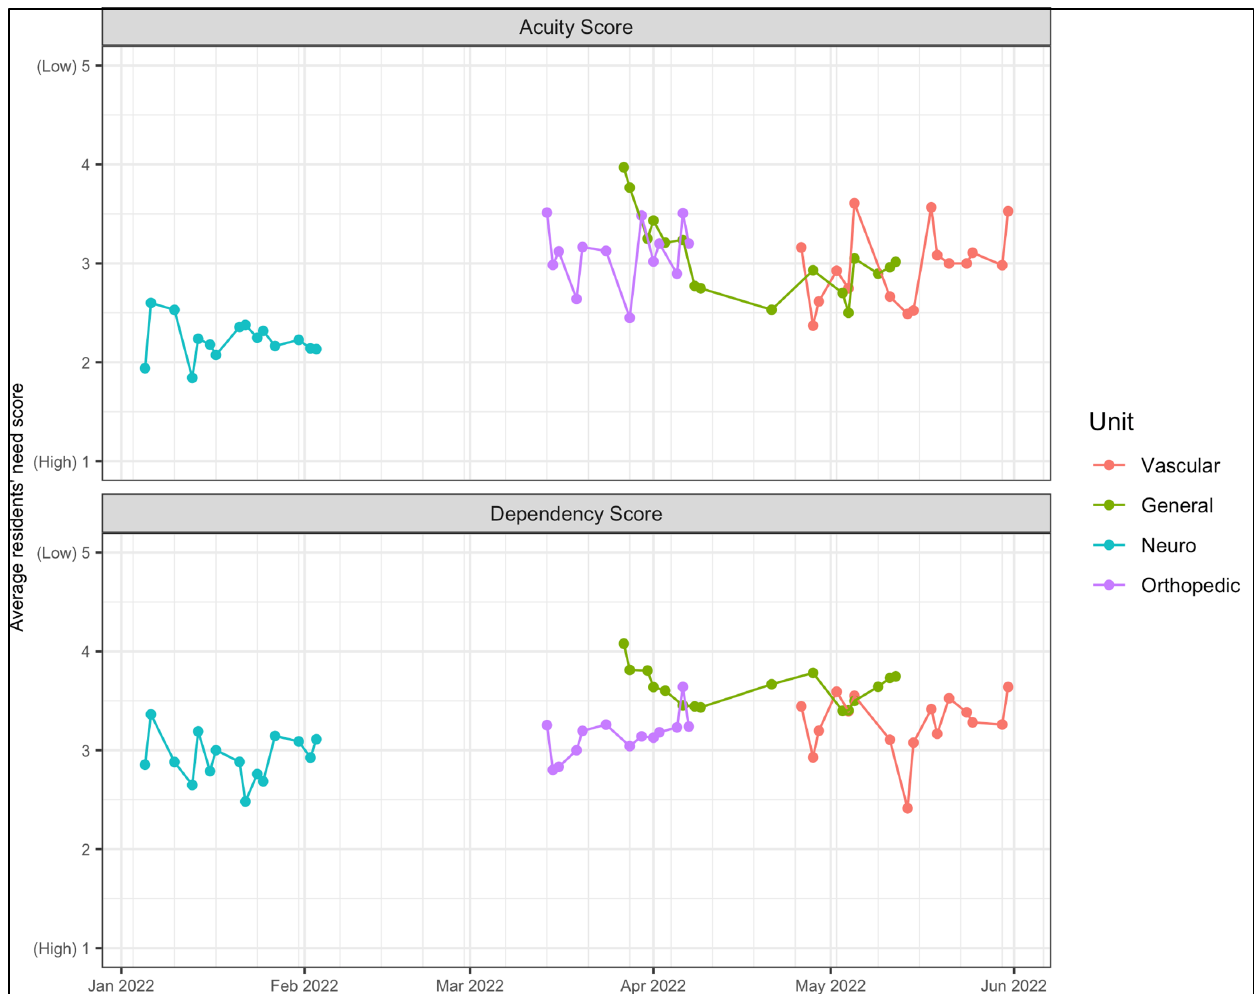
Figure 1. Trends Overtime in Patient Acuity and Dependency Scores across each Unit. Table 4. Nurse staffing recommendations informed by Synergy